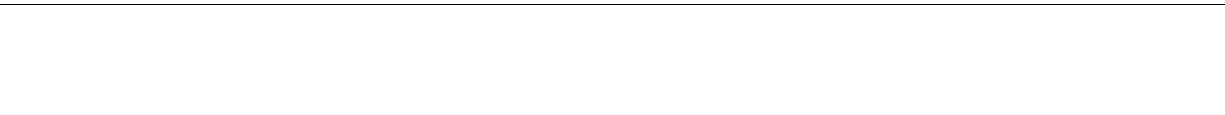
FIGURE5| PhenotypeandgenotypedistributionsinEuropeancountries. (A) Themapshowsthenumbersandpercentagesofexaminedpatients.Piechartsshow (B) the phenotypes and (C) genotypes of positive cases.